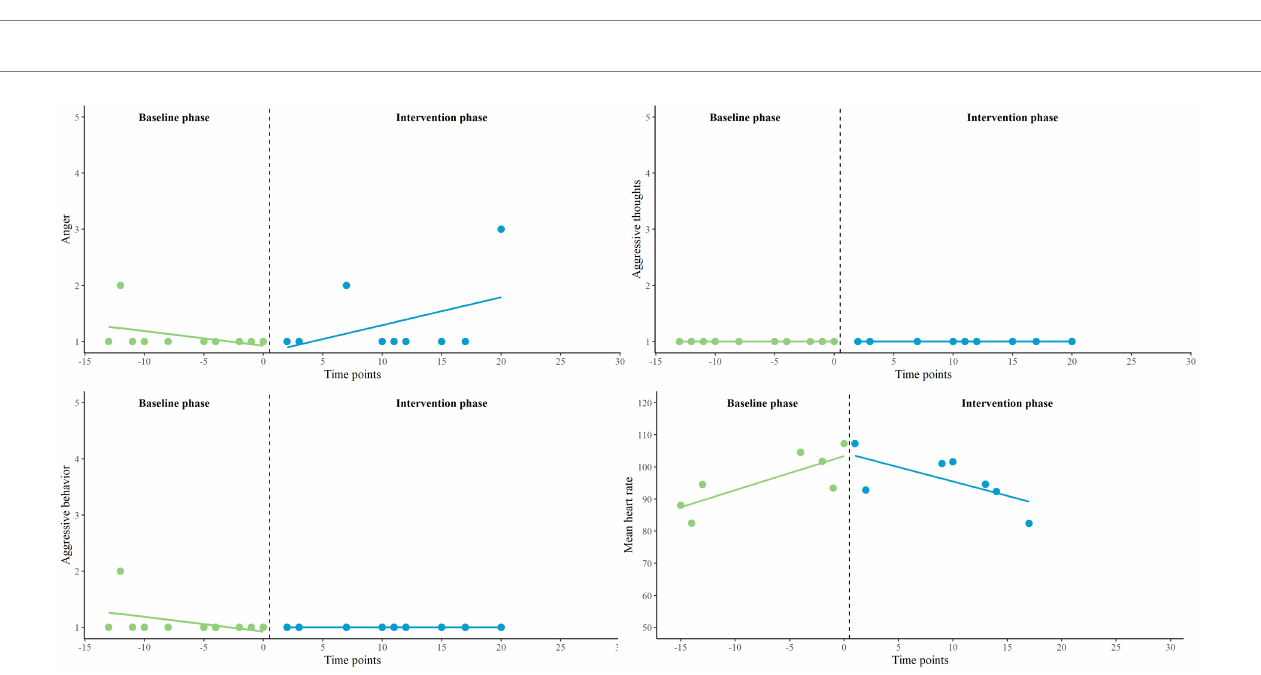
FIGURE 6 Representation of Eric’s EMA measures (anger, aggressive thoughts and aggressive behavior) and HR (average), measured twice a day on a 5-point Likert scale, in baseline (A 1 ) and intervention phase